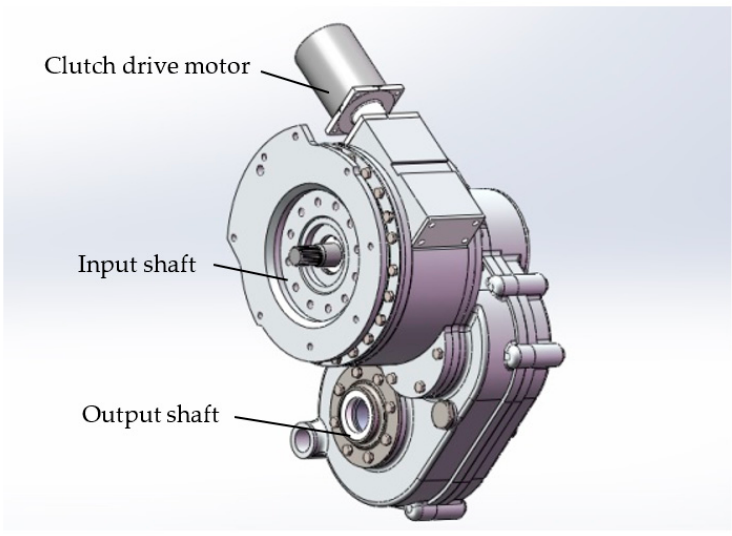
Figure 1. Planetary gear automatic transmission with electrically controlled wedge clutch.